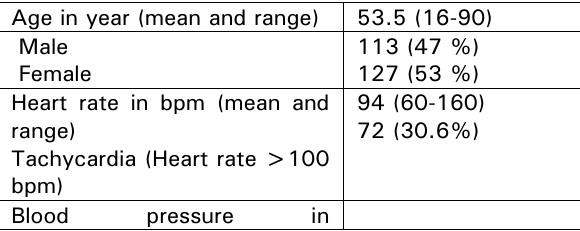
Table 1: Clinical characteristics of